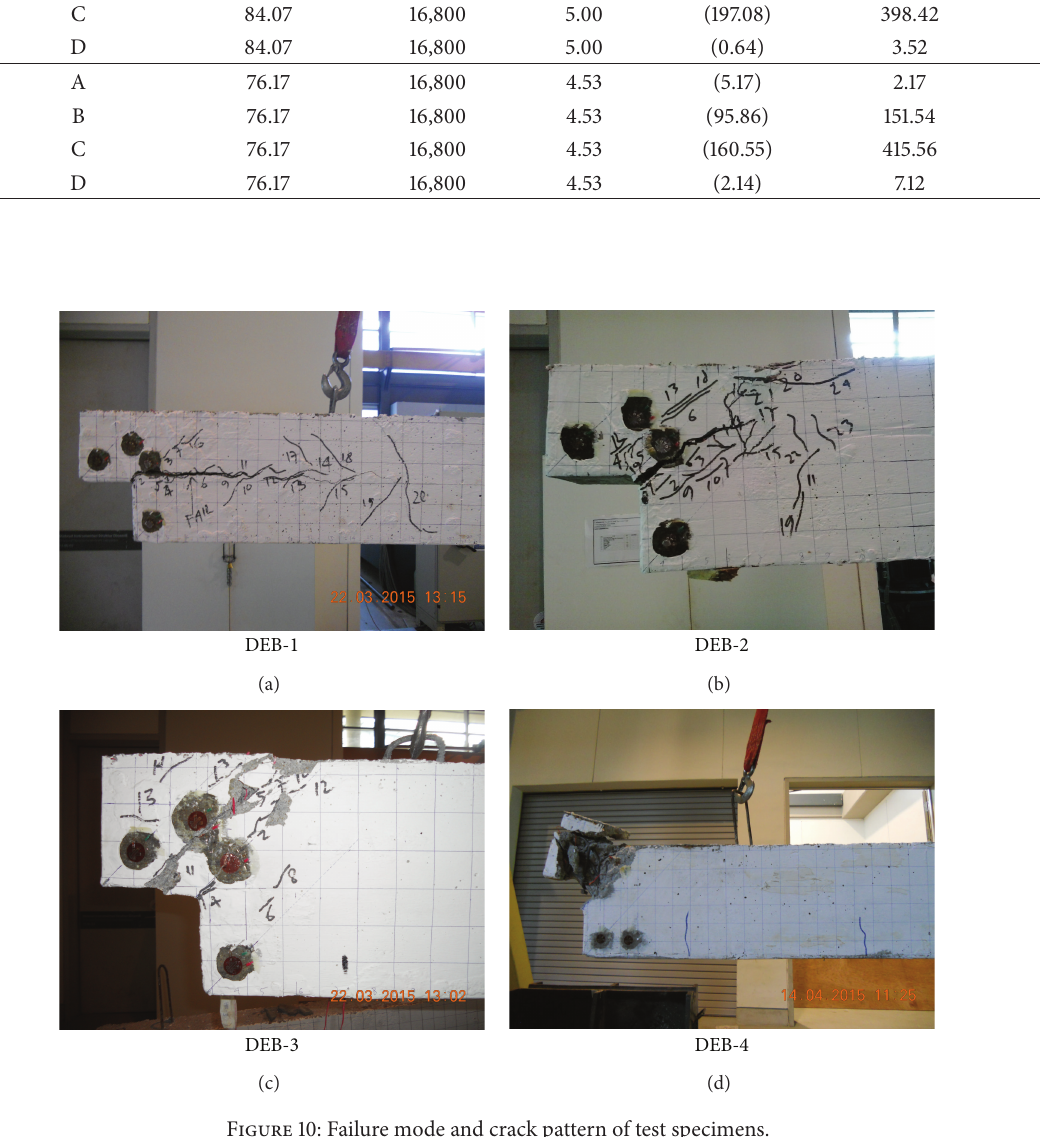
Figure 10: Failure mode and crack pattern of test